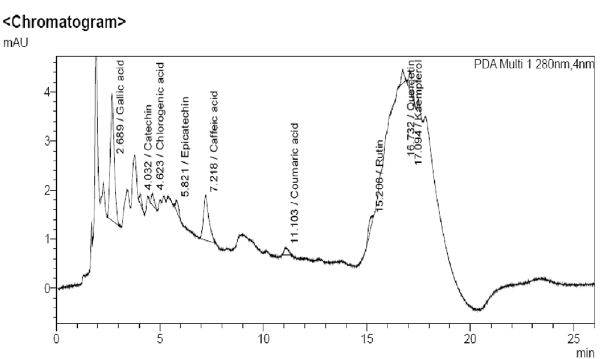
Figure 4. UHPLC chromatogram of the ethyl acetate extract of S. commune detected at 280